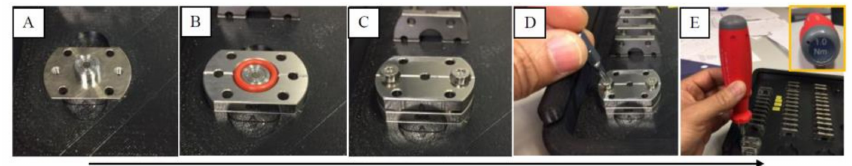
Figure 7. Assembling of the diamond liquid cells (DLC) for the exposure of THz radiation (A–E). ( A ) DLC before loading the sample. ( B ) PC 12 cells were loaded into the DLC with the 300 µ m spacer. ( C ) DLC after loading the sample in. ( D ) The three stainless steel components were assembled together. ( E ) The components of the DLC were fitted in place using a screwdriver (Torque 1.0 Nm). After loading the sample, the DLC was viewed under a microscope to confirm the absence of air bubbles.